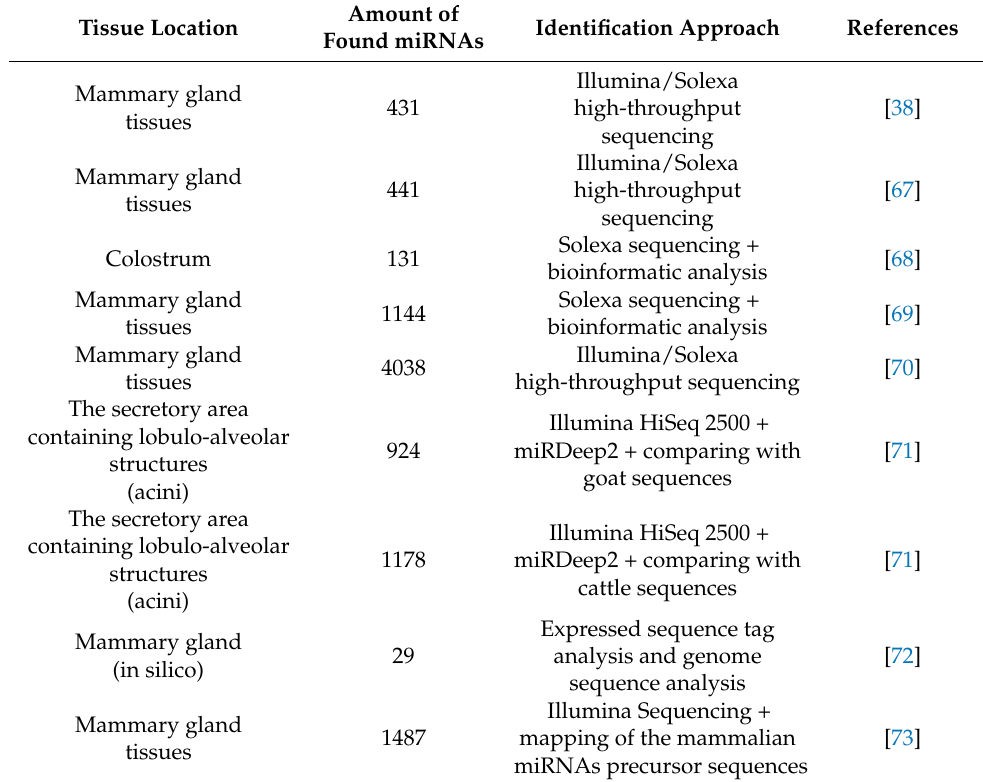
Table 2. A brief summary of all miRNAs ever found in goat mammary